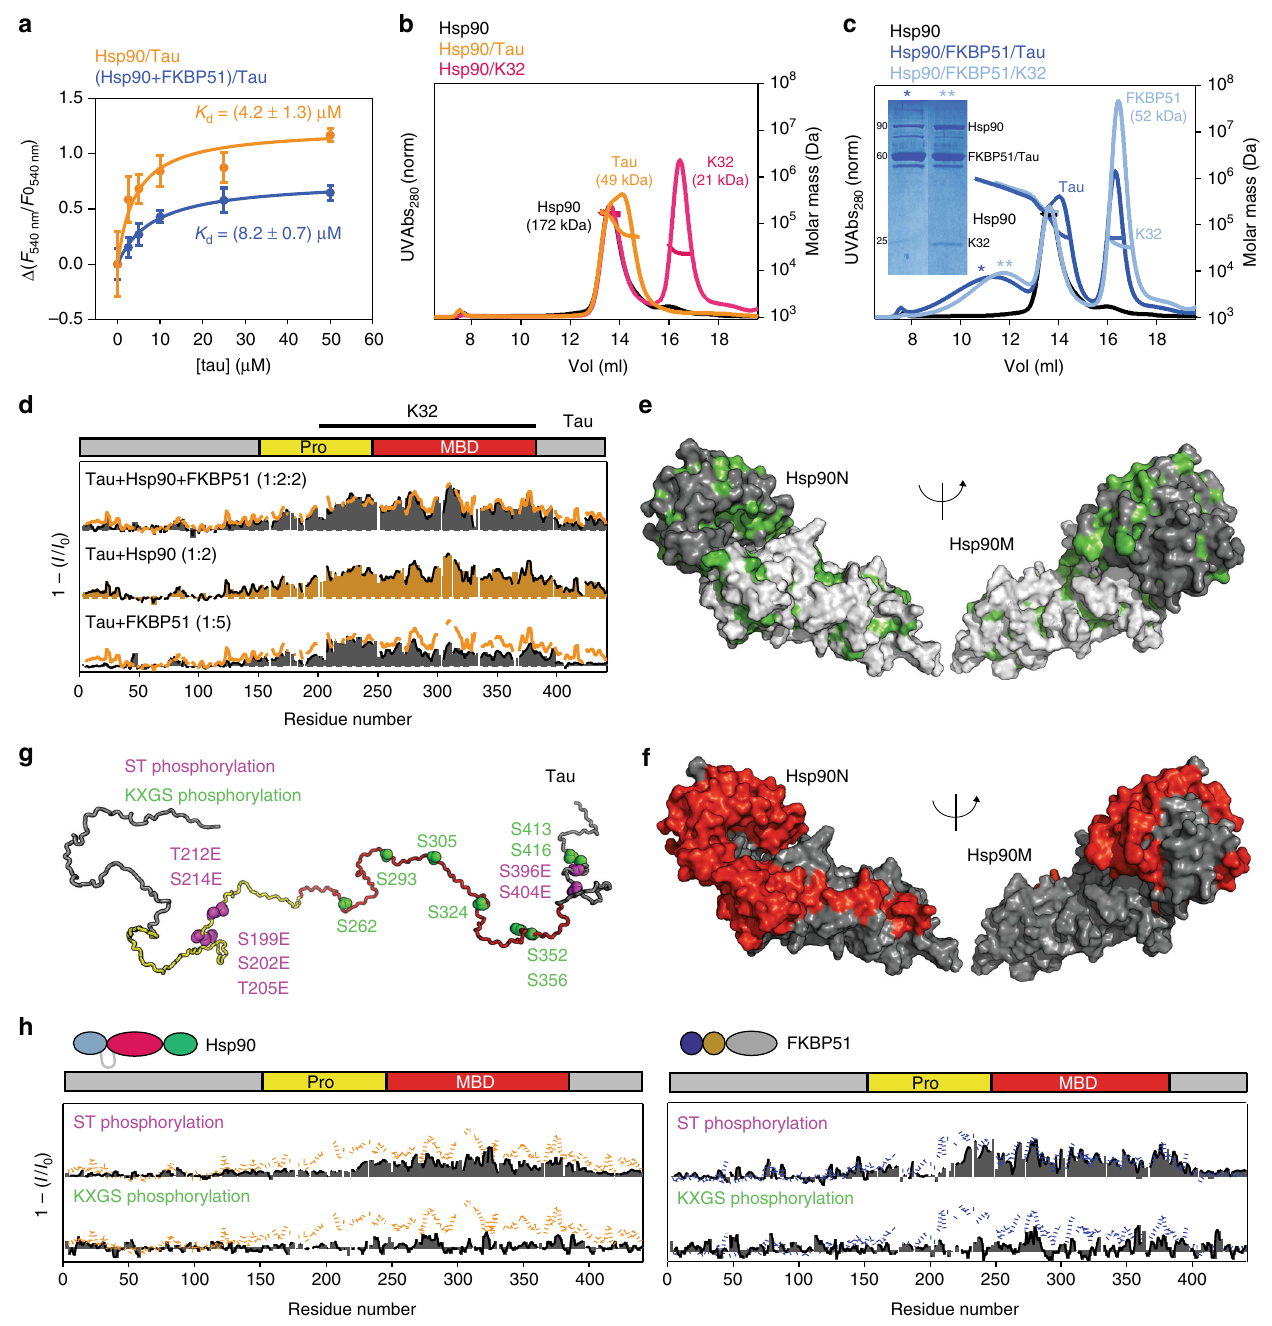
Fig. 4 Phosphorylation-dependent complexation of Tau. a Binding af fi nity of Tau to Hsp90 is slightly decreased by the presence of FKBP51. Reported are average values of triplicate experiments ± SD. b The dynamic complex formed by Hsp90/Tau dissociates on the SEC column. c The presence of FKBP51 stabilizes the ternary complex. Fractions corresponding to the ternary complex (represented by asterisks) were submitted to SDS-PAGE showing the presence of the three proteins in the Hsp90/FKBP51/Tau and Hsp90/FKBP51/K32 ternary complexes. Note that FKBP51 and 441-residue Tau co- migrate in the gel resulting in overlapping bands on SDS-PAGE. Both full-length Tau and the K32 fragment 16 were used, to illustrate the reproducibility of the results. MALS fi ttings for molecular weight estimation are indicated. Note that Tau retention times are comparable to those of much larger proteins, due to its disordered structure. The uncropped gel is shown in Supplementary Figure 8. d NMR interaction pro fi les of 441-residue Tau with Hsp90 (orange; Tau/Hsp90 molar ratio of 1:2), FKBP51 (bottom; Tau/FKBP51 molar ratio of 1:5) and the Hsp90/FKBP51 complex (top). I 0 and I are intensities of H – N cross-peaks of Tau in the absence and presence of the binding partner, respectively. For comparison, the binding pattern to Hsp90 is represented in the Tau/FKBP51 and Tau/Hsp90/FKBP51 plots by orange lines. The region covered by K32 fragment is shown on top. e Hydrophobic residues (green) in the N/M domains of Hsp90. f PREs induced in Hsp90 domains (red) by binding of Tau tagged with MTSL at position 256 within the binary Hsp90/Tau complex. g Phosphorylation of Tau impedes binding to Hsp90 and FKBP51. Cartoon representation indicating KXGS phosphorylation sites in Tau (green 41 ), as well as sites for Ser-Thr pseudo-phosphorylation detected by AT8, AT100, and PHF1 antibodies (purple 42 ). h NMR binding plots of Ser-Thr pseudo- phosphorylated (purple) and MARK2-phosphorylated (green) Tau to Hsp90 (left) and FKBP51 (right). For comparison, the binding pro fi les of wild-type Tau (dotted lines) are